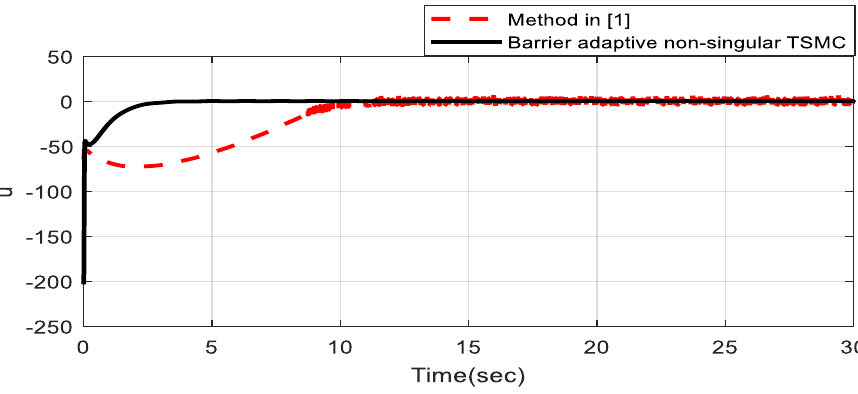
Figure 5. Time responses of the barrier function and adaptive law.